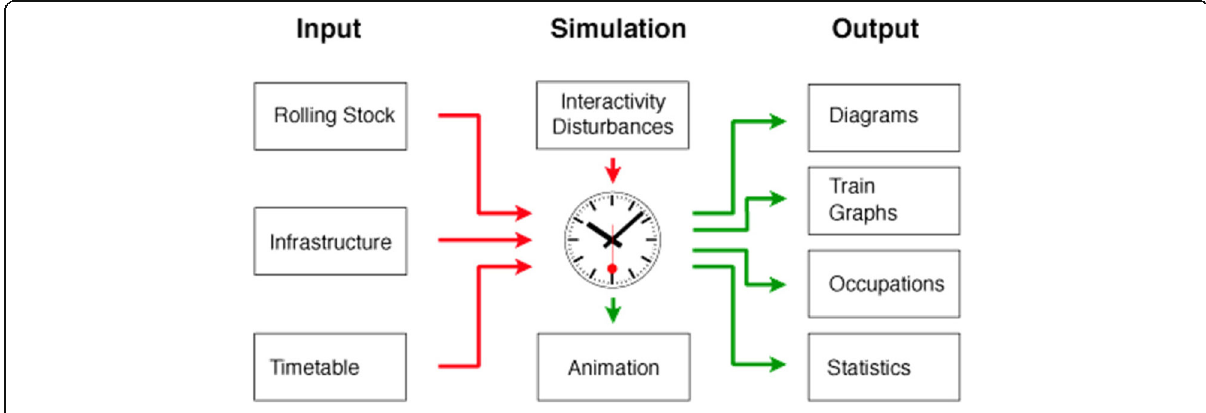
Fig. 7 Simulator operation process